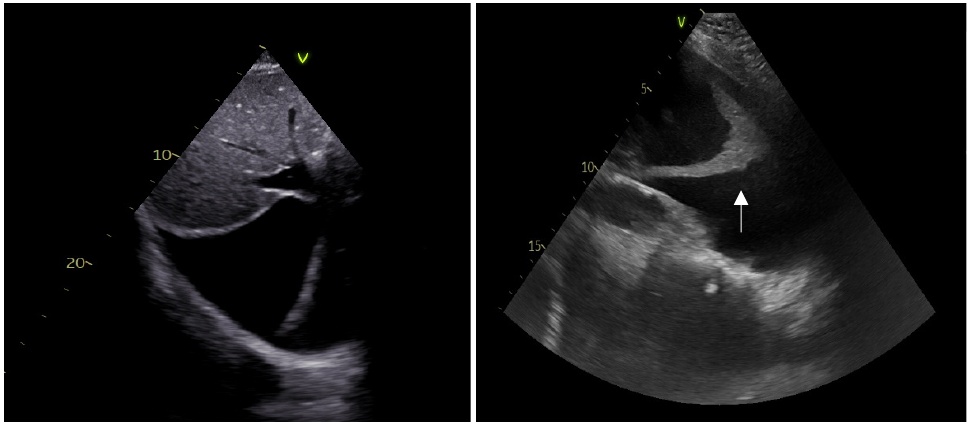
Figure 3. Pleural effusion with lung region floating inside